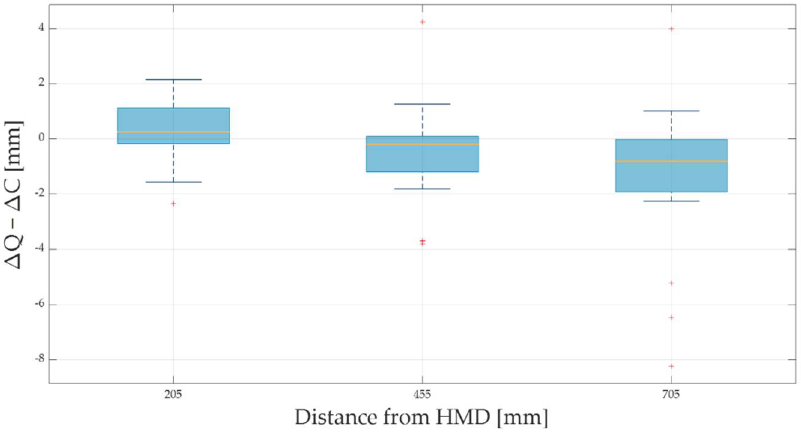
Figure 7. Error corresponding to the increment of 5 mm at the distances of 205 mm, 455 mm, and 705 mm from the head-mounted display (HMD).